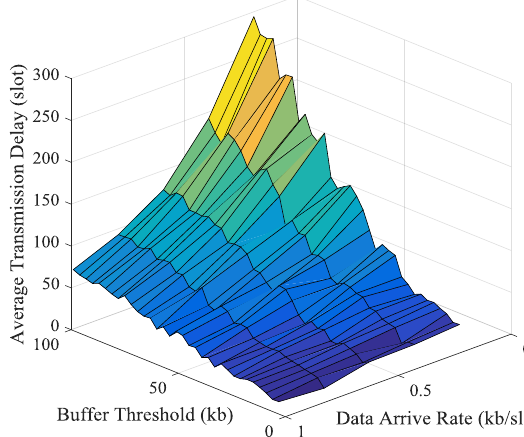
Figure 33. Simulation results of the impact of buffer threshold and data arrival rate on the average transmission delay.